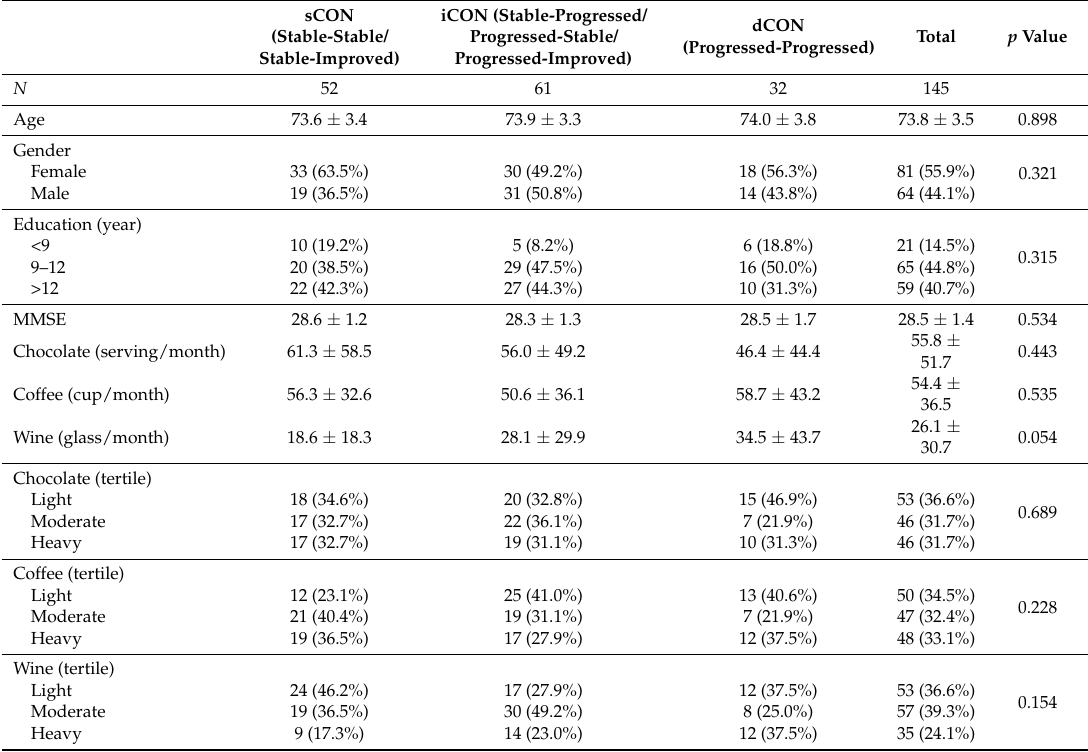
Table 1. Clinical, demographic and substance data by evolution groups.